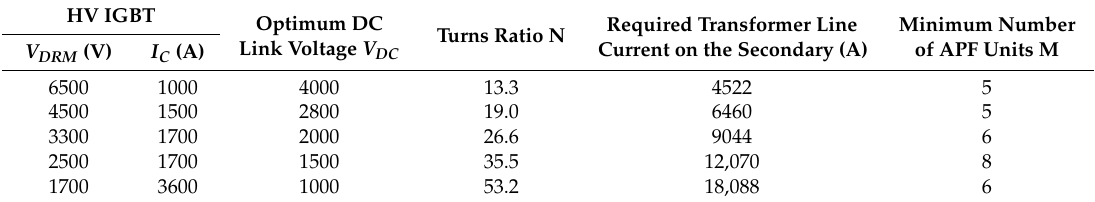
Table 4. Optimized design parameters for the coupling transformer and shunt APF units. HV